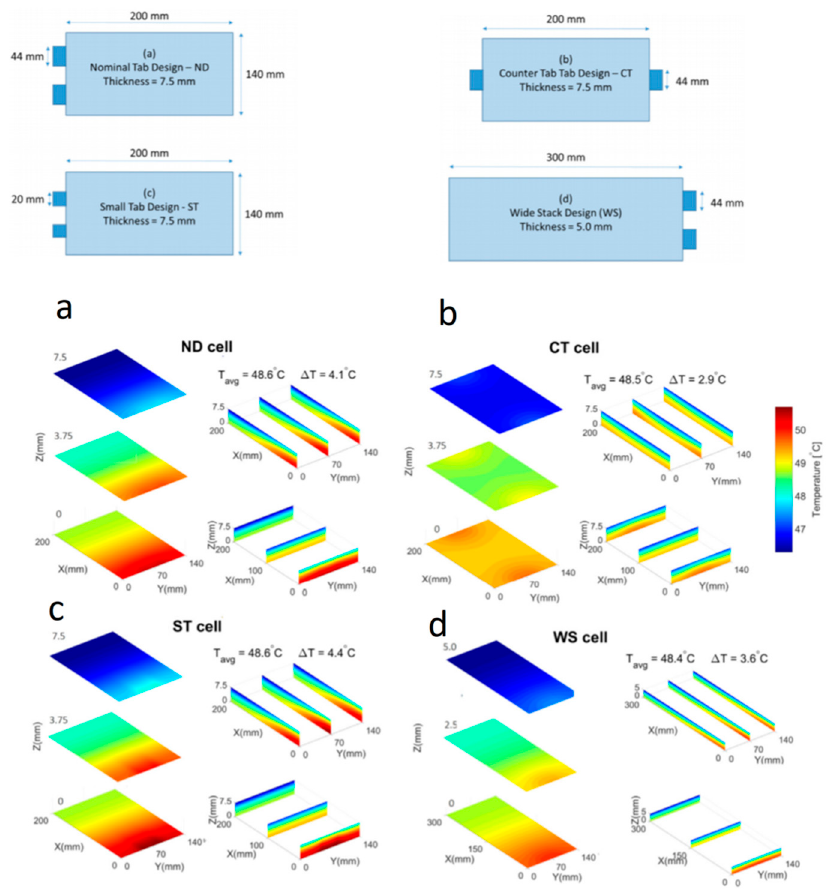
Figure 3. Design of pouch cell electrode (upper); distribution of temperature at nine cross-sectioned surfaces in cell composite volume at the end of 6 C constant charge: ( a ) ND cell, ( b ) CT cell, ( c ) ST cell, ( d ) WS cell (bottom) [6]. Reproduced by permission of Elsevier.